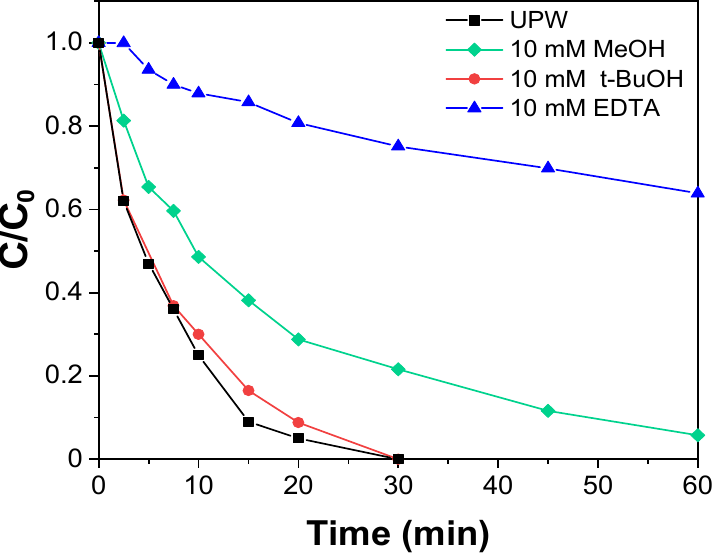
Figure 11. Effect of reactive species scavengers on SMX degradation. Experimental conditions: 0.5 mg/L SMX, 100 mg/L SPS, and 500 mg/L catalyst 3.0 Cu.BVO. To shed light on the contribution of sulfate radicals, the consumption of SPS was measured in the presence and absence of the photocatalyst or solar irradiation. The consumption of SPS was significantly higher in the hybrid system than in the individual processes, as shown in Figure 12.